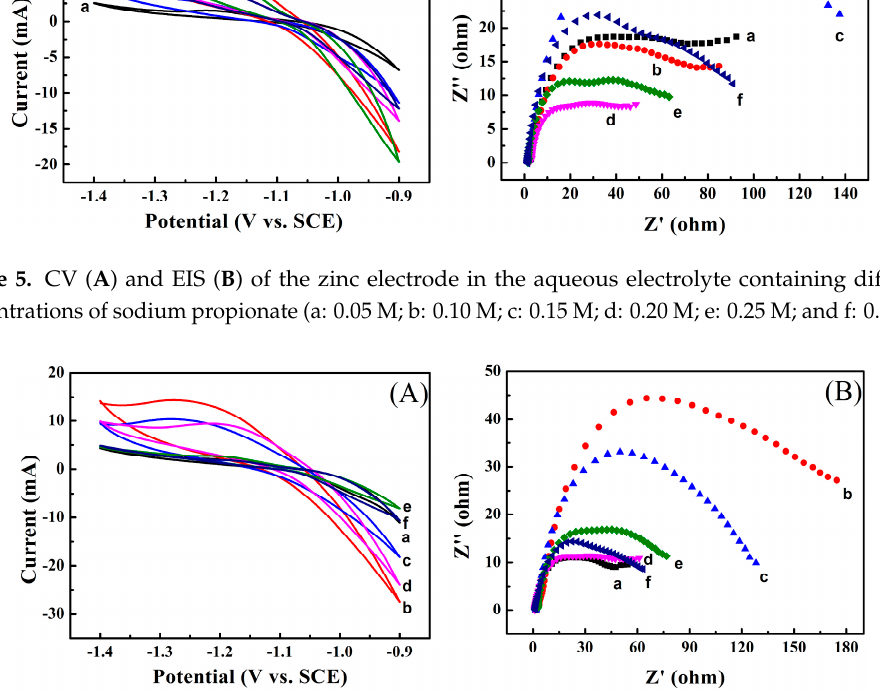
Figure 6. CV ( A ) and EIS ( B ) of the zinc electrode in the aqueous electrolyte containing different concentrations of disodium malonate (a: 0.05 M; b: 0.10 M; c: 0.15 M; d: 0.20 M; e: 0.25 M; and f: 0.30 M).